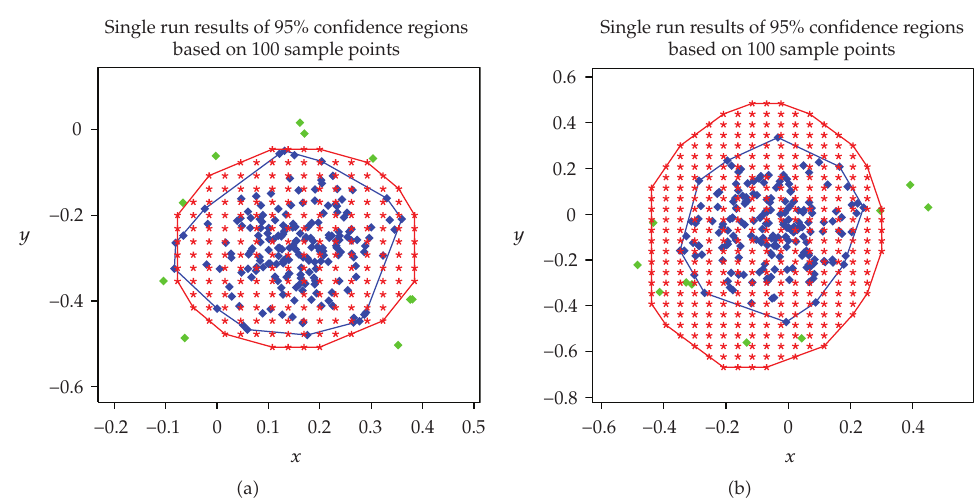
Figure 3: 95% confidence regions by T 2 (cid:2) red one (cid:3) and new procedures (cid:2) blue one (cid:3) for the mean of F based on 100 sample points from F : (cid:2) a (cid:3) F (cid:4) N 2 (cid:2) 0 , 1 (cid:3) , (cid:2) b (cid:3) F (cid:4) t 2 (cid:2) 3 (cid:3)